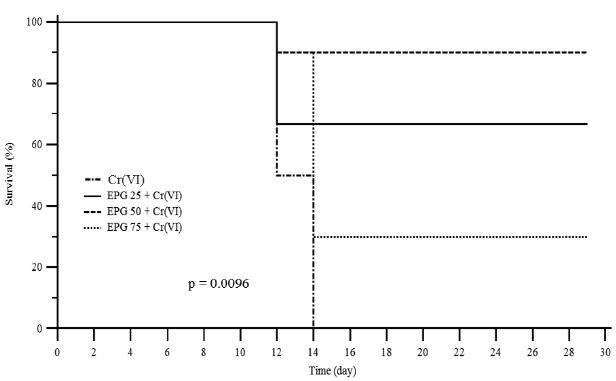
FIGURE 3 - Survival analysis of animals prophylactically t r e a t e d w i t h d i ff e r e n t P G E d o s e s ( 2 5 , 5 0 a n d 75 mg/kg/day) for 10 days and exposed to a lethal dose of Cr(VI) (50 mg/kg) on the 11 th day. The survival rate was monitored until the 30 nd day. (p = 0.0096. Kaplan-Meier test and Log-Rank test,